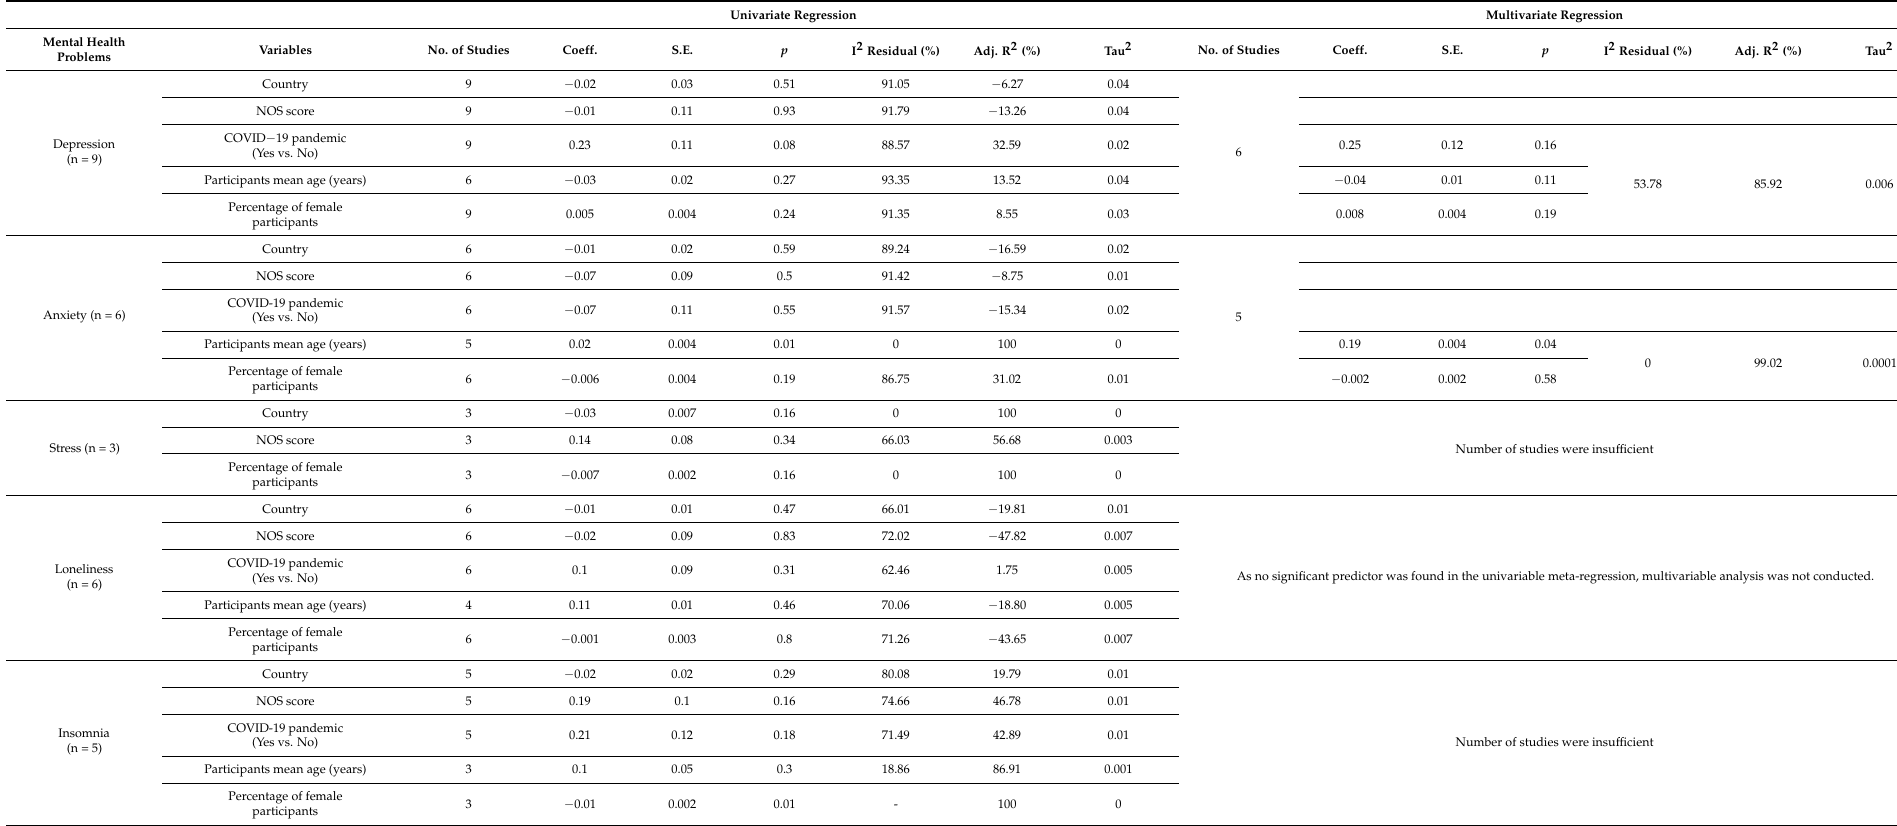
Table 4. The results of the meta-regression analysis in association between binge-watching and mental health problems. UnivariateRegression MultivariateRegression MentalHealth Problems Variables No.